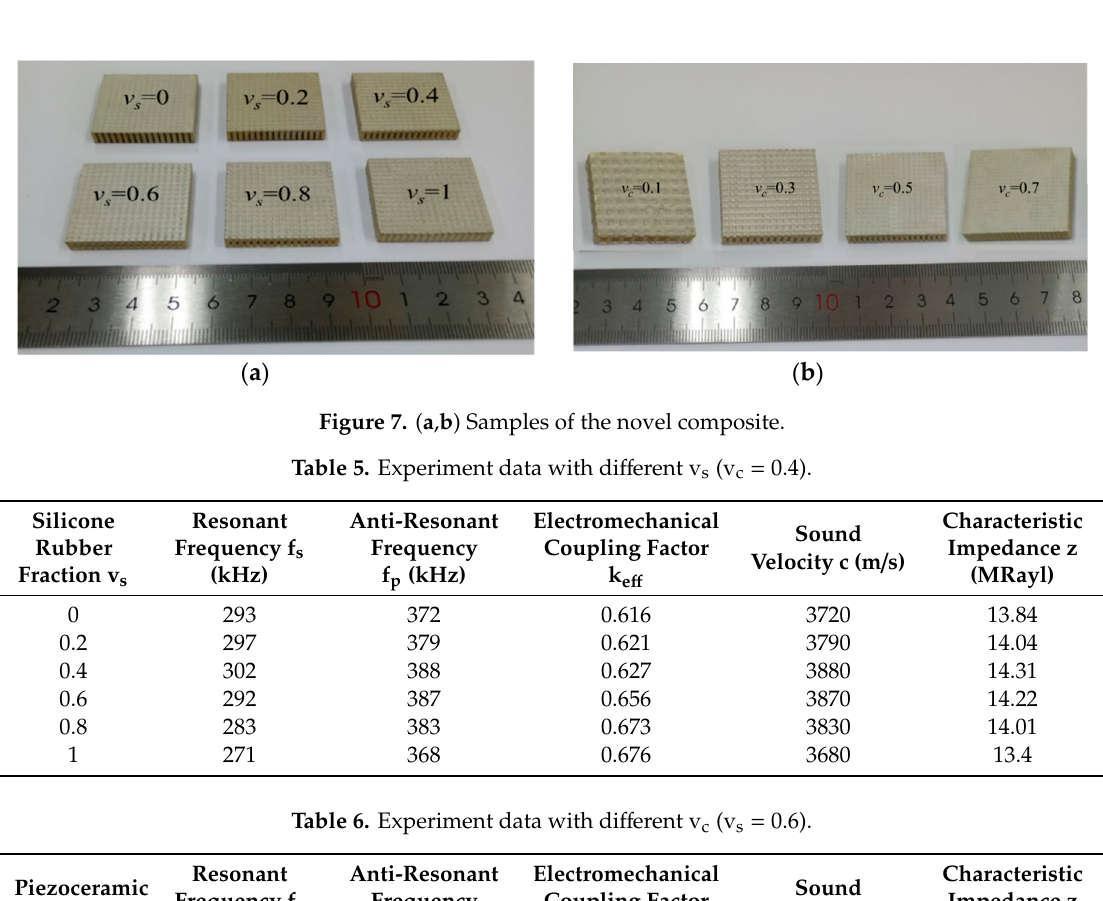
Figure 6. Preparation process of the novel composite.